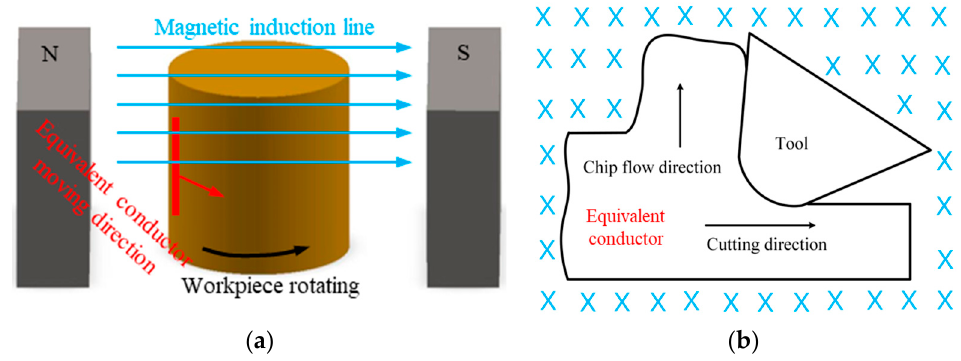
Figure 7. Equivalent conductor cuts the magnetic-induction line in the cutting process, ( a ) workpiece rotating in magnetic field, ( b ) equivalent-conductor-cut magnetic line.